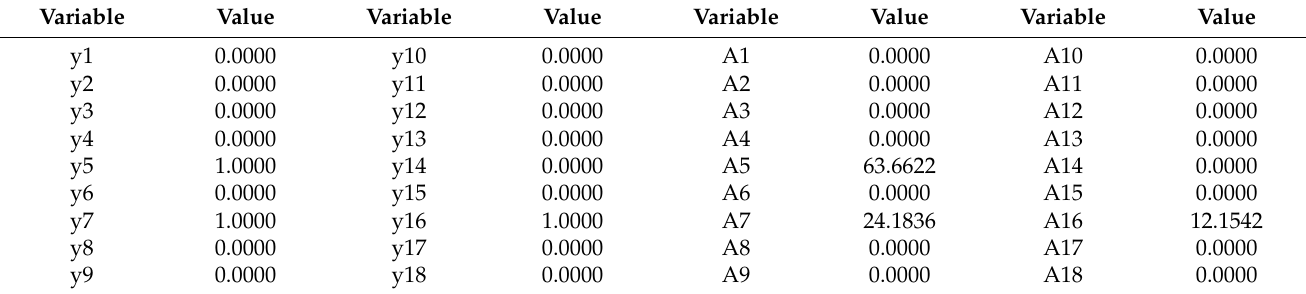
Table 8. The investment portfolio design results of the out-of-sample data.